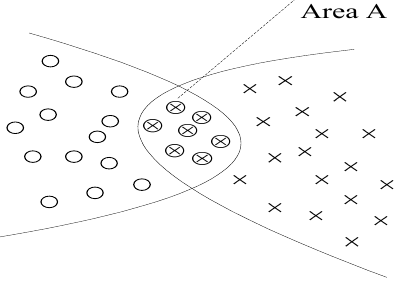
Figure 3. The example of data